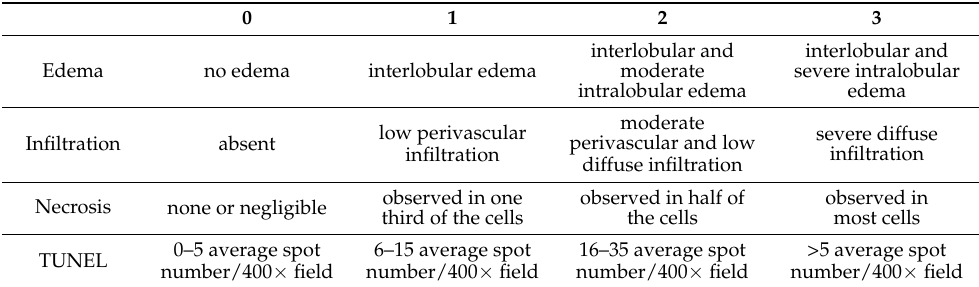
Table 2. Histologic scoring of tissue